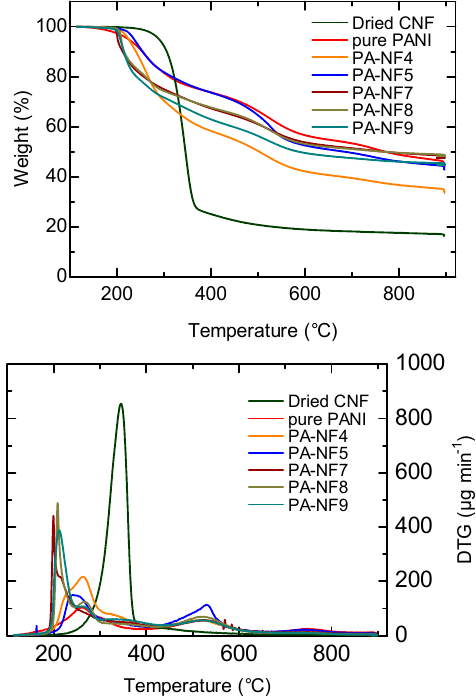
Figure 9. Thermogravimetry analysis (TGA) ( top ) and differential thermogravimetry (DTG) ( bottom ) of dried CNF, pure PANI, PA-NF4, and PA-NF-5, PA-NF7, PA-NF-8, and PA-NF-9.